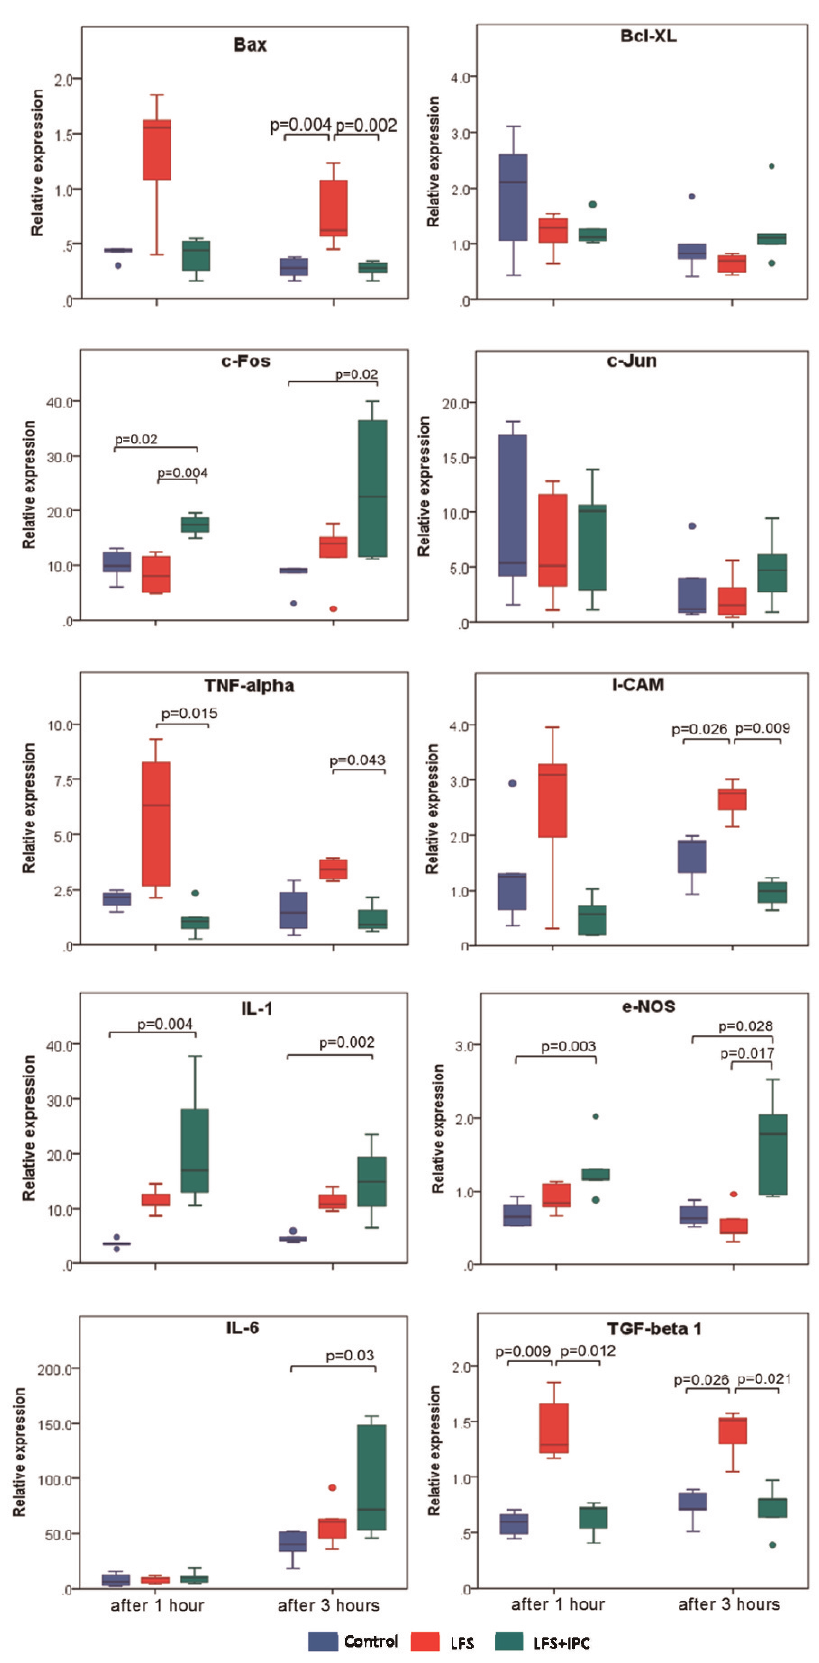
Figure 4 - The results of molecular analyses. Note the positive effects of IPC on gene